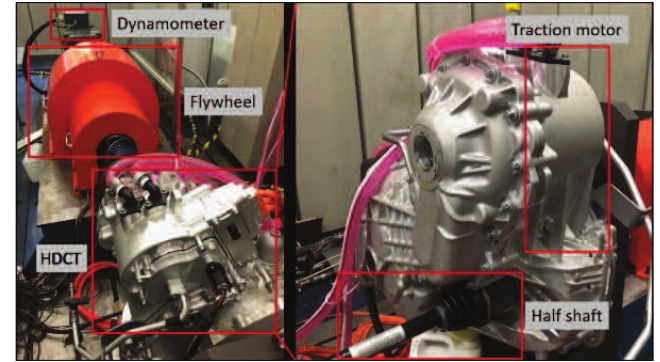
Figure 9. Test bench for the hybrid DCT powertrain system.